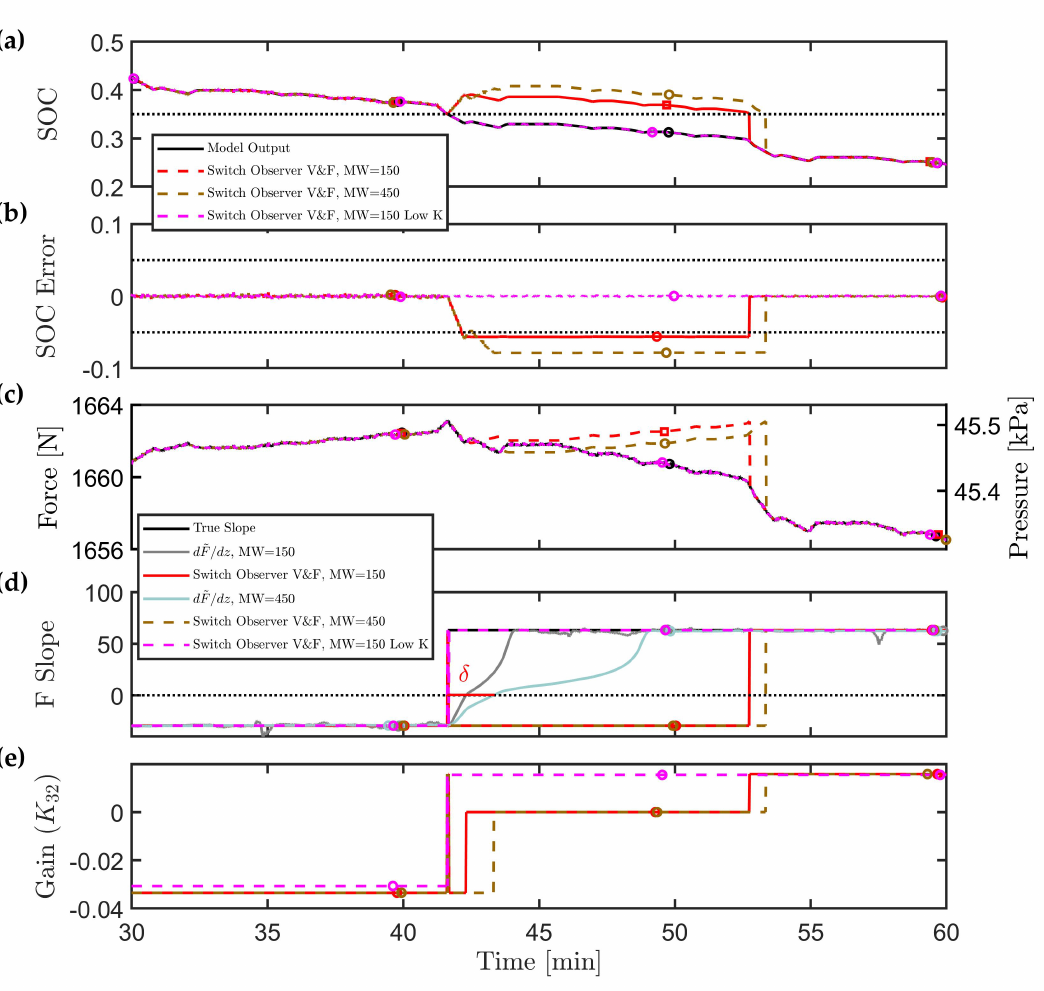
Figure 5. Simulation (without bias in the force measurement) for the Switch Observer V&F developed in our previous work [22]. This figure shows the impact of high gains corresponding to solution of the linear quadratic estimator using Q 1 = diag ([ 2,0.1,0.1 ]) and R = diag ([ 1,1 ]) with moving windows of length (MW) = 150 and MW = 450. If the gain is lowered by using Q 2 = diag ([ 2,0.1,1 e − 2 ]) , as shown by the purple dashed line, the error is decreased by 5% with same 150pt moving window length. ( a ) Comparison of the simulated state of charge (SOC). ( b ) Comparison of the state of charge (SOC) error with the dashed lines representing the target ± 5% bound. ( c ) Comparison of the simulated force. For generalization of the results to the other cell sizes, the pressure is shown. ( d ) Comparison of the true slope with the estimated slope d ˜ F and observer output. Due to the greater delay ( δ ) before applying dz the zero gain for the MW = 450 case, a higher error in SOC estimation occurs during the transition from R II to R I . ( e ) Comparison of the feedback gain K 32 from force to SOC based on the switching logic. When the observer and estimated slopes mismatch, the gain is set to